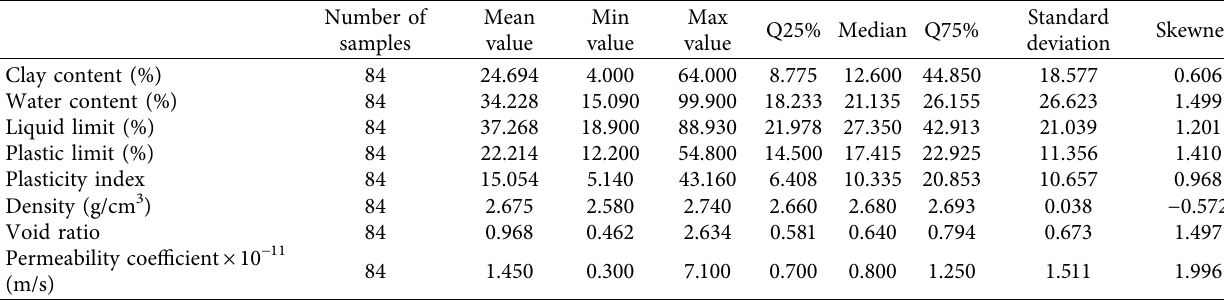
Figure 1: Simplest linear correlation between permeability coefficient and each input variable. Table 1: Distribution value of